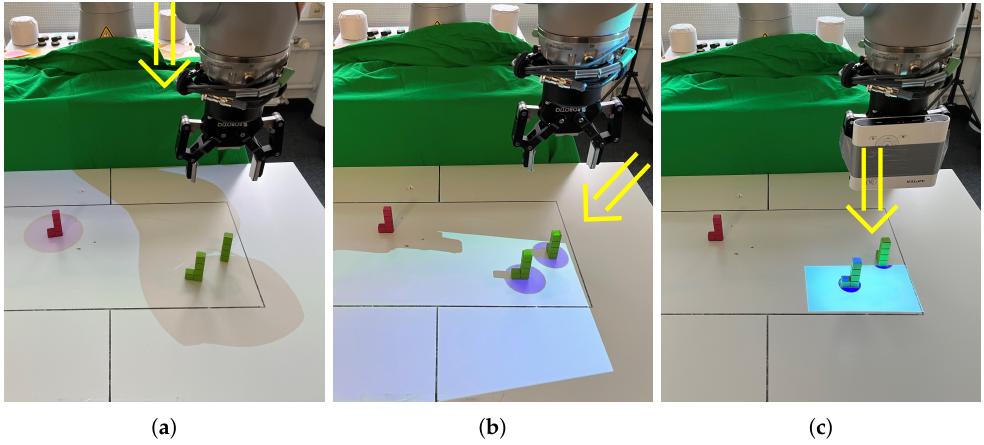
Figure 3. For our work, we compared three different mounting-settings of a projector in the cobot’s workspace to communicate cobot perception. The compared settings are ( a ) top-mounted; ( b ) side-mounted; and ( c ) cobot flanch-mounted projection. The direction of the projection is indi- cated by an